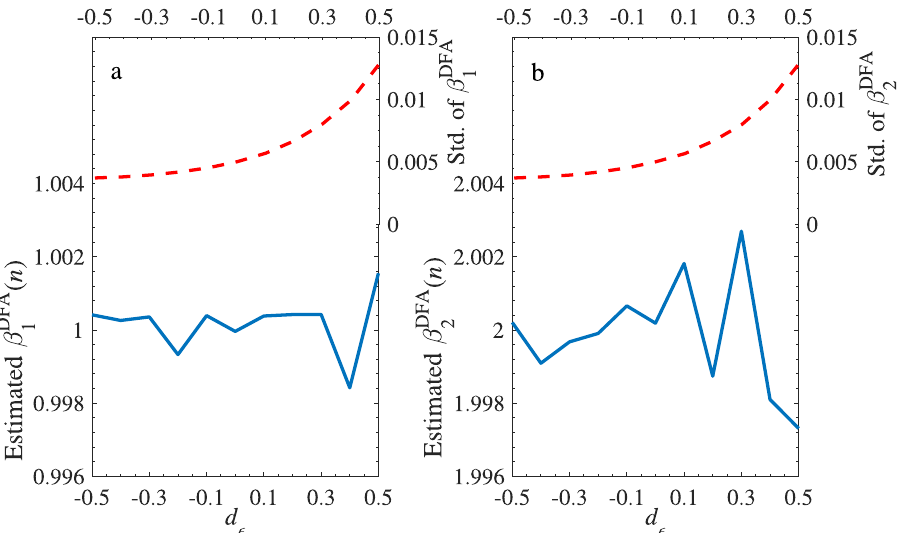
Figure 2. Estimated two DFA Regression coefficients with setting II of ARFIMA model with the same legend as in Fig. 1. X 1 and X 2 are generated by ARFIMA series with the same fixed d = 0.4. ε is an ARFIMA process with changing parameter d ε ( x -axis). The remaining settings are the same as those in case I. Results show that the DFA estimators β 1 and β 2 are unbiased at 1 and 2 with the error-term ± 0.002 and ± 0.003, respectively, while the standard deviations increase with the error-term memory